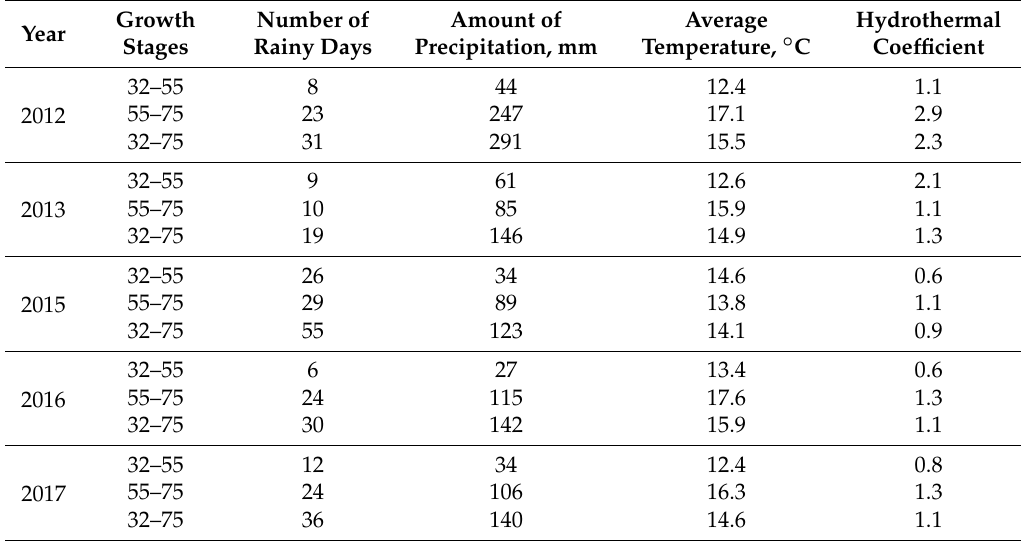
Table 1. Meteorological situation during the period of